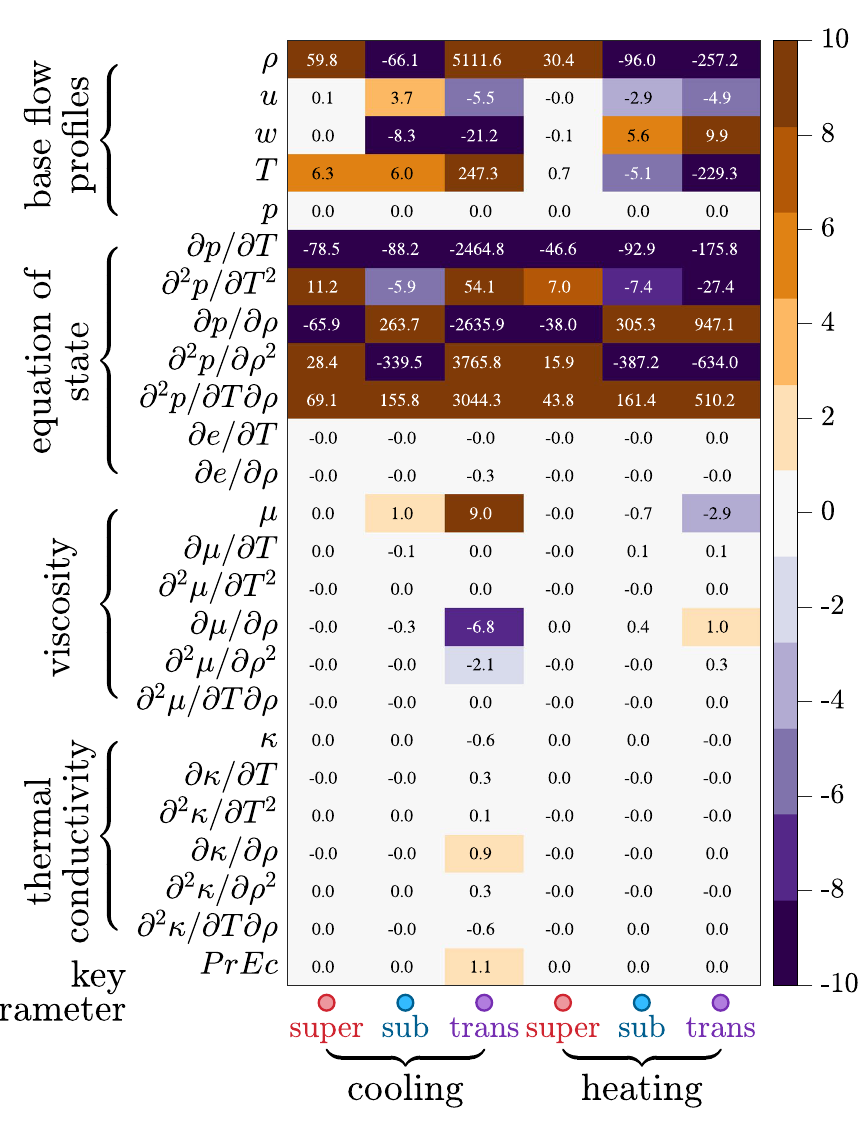
Figure 4. Sensitivity ǫ of the spatial growth rate to different inputs of the stability operator. These inputs correspond to different categories shown in Fig. 1a. The six columns are for supercritical, subcritical, and transcritical regimes with wall cooling and heating conditions, respectively (see bottom of the